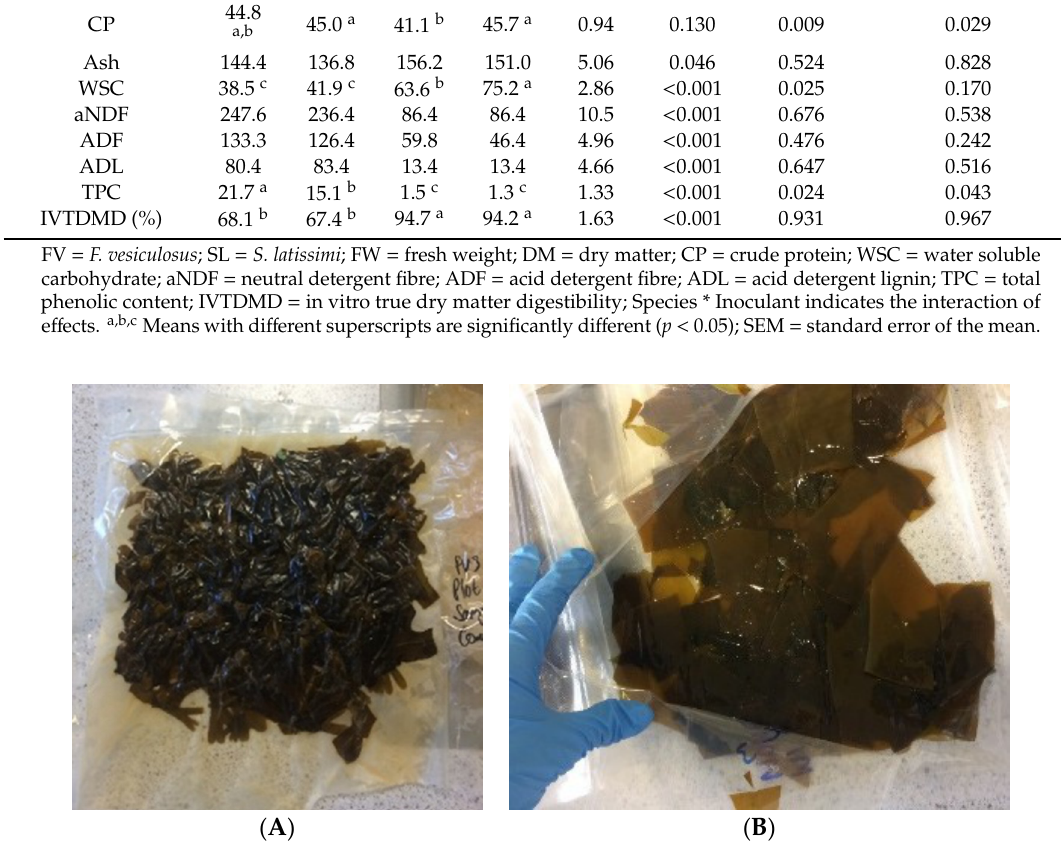
Figure 3. Seaweed silage (( A ) F. vesiculosus , ( B ) S. latissimi ) after a 90-day storage period.